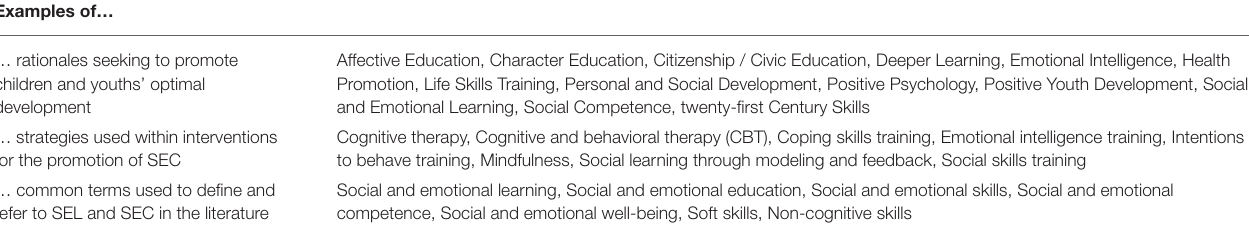
TABLE 1 | Synthesis of the multiple dimensions that increase the complexity of identifying and bordering the SEL rationale [based on the works of Elias et al. (1997), Durlak et al. (2015), Tolan et al. (2016), and Cefai et al. (2018)]. Examples of… … rationales seeking to promote children and youths’ optimal